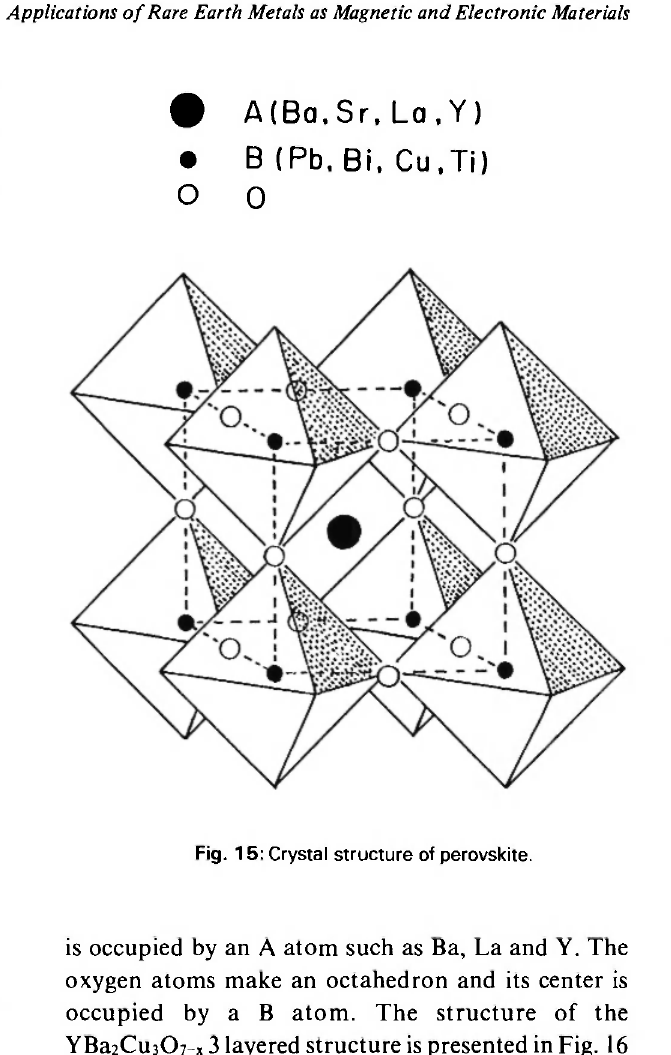
Fig. 15: Crystal structure of